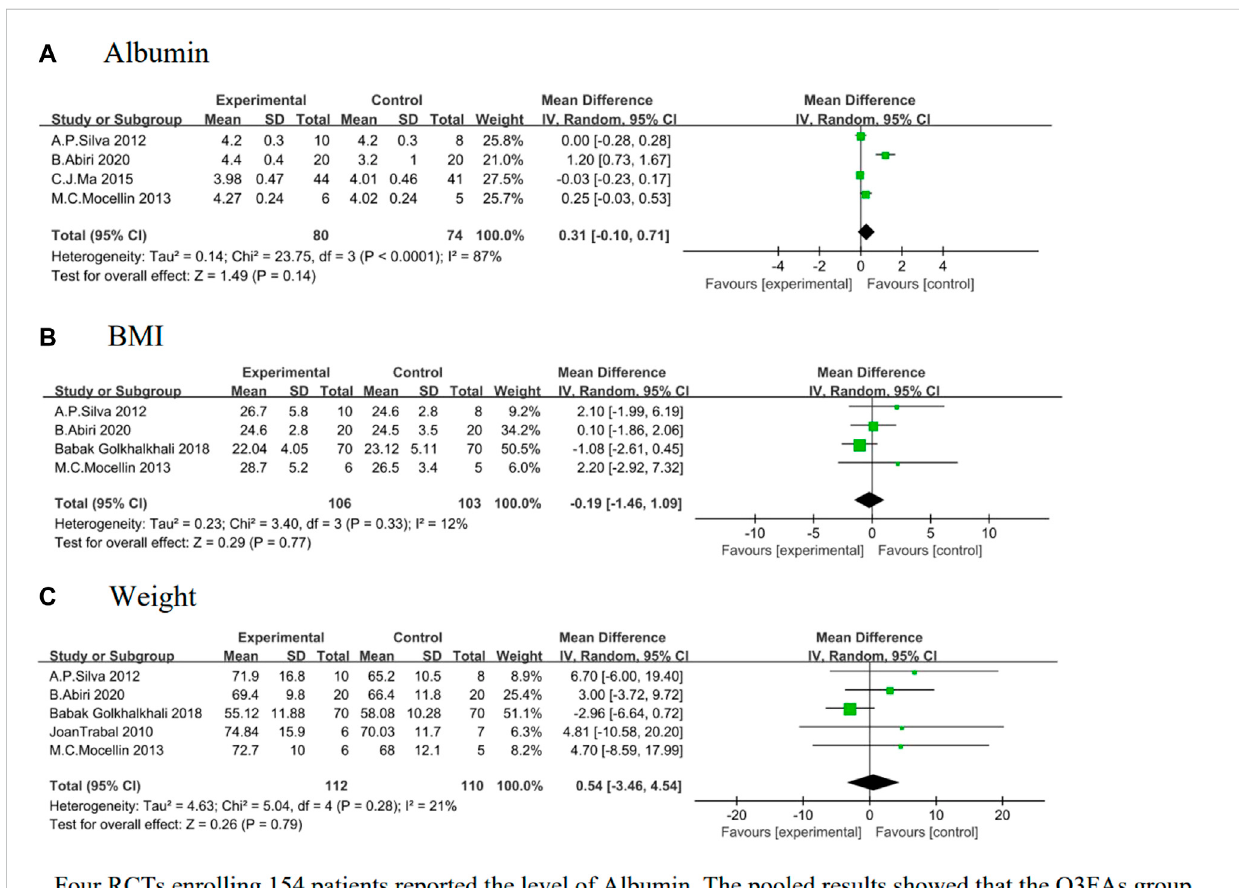
FIGURE 4 Effect of O3FAs on postoperative nutritional status (A) : Alubumin, (B) : BMI, (C) : Weight.